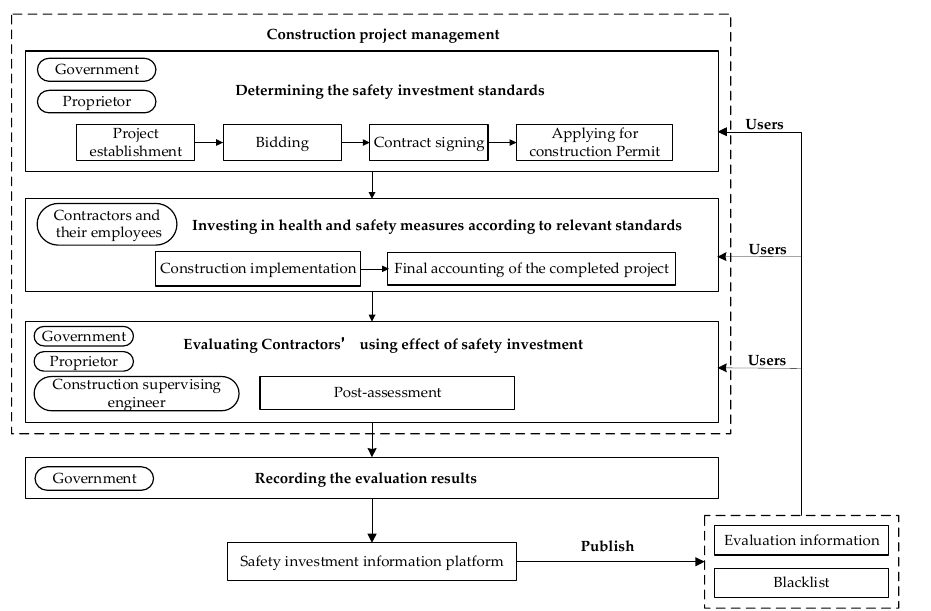
Figure 3. Structural diagram of the safety investment information system.